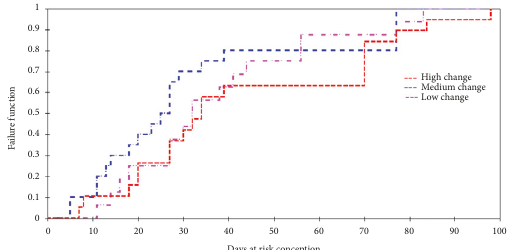
Figure4:Kaplan-Meier’scurvefortimetoconceptionin Bosindicus cows from two farms located in the dry tropical climate of Mexico and Costa Rica. No major differences were observed in the medium and low FAT changes whereas the cows with high changes were statistically different (P <